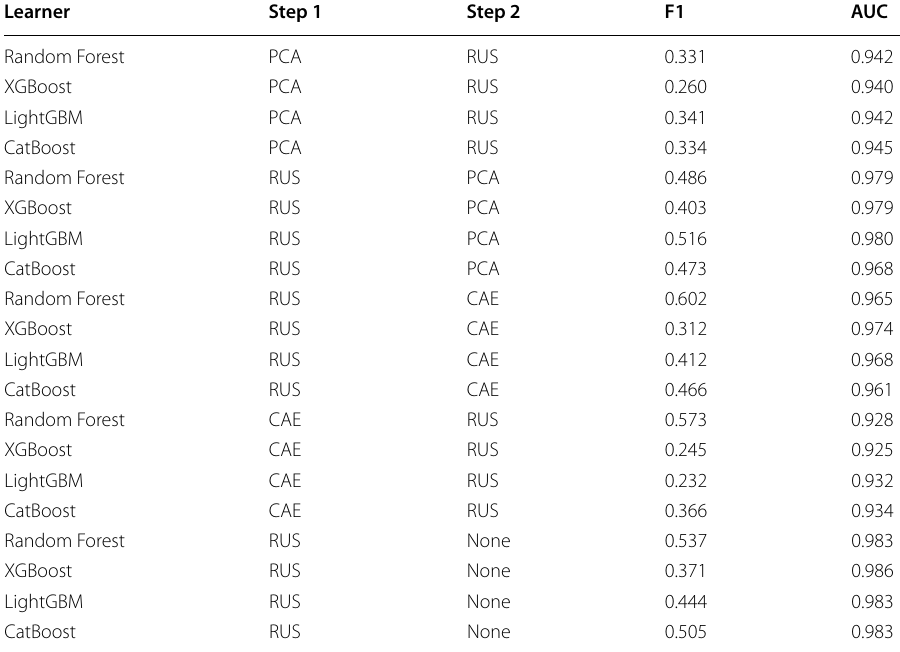
Table 4 Performance scores for RUS (1:5 ratio) Learner